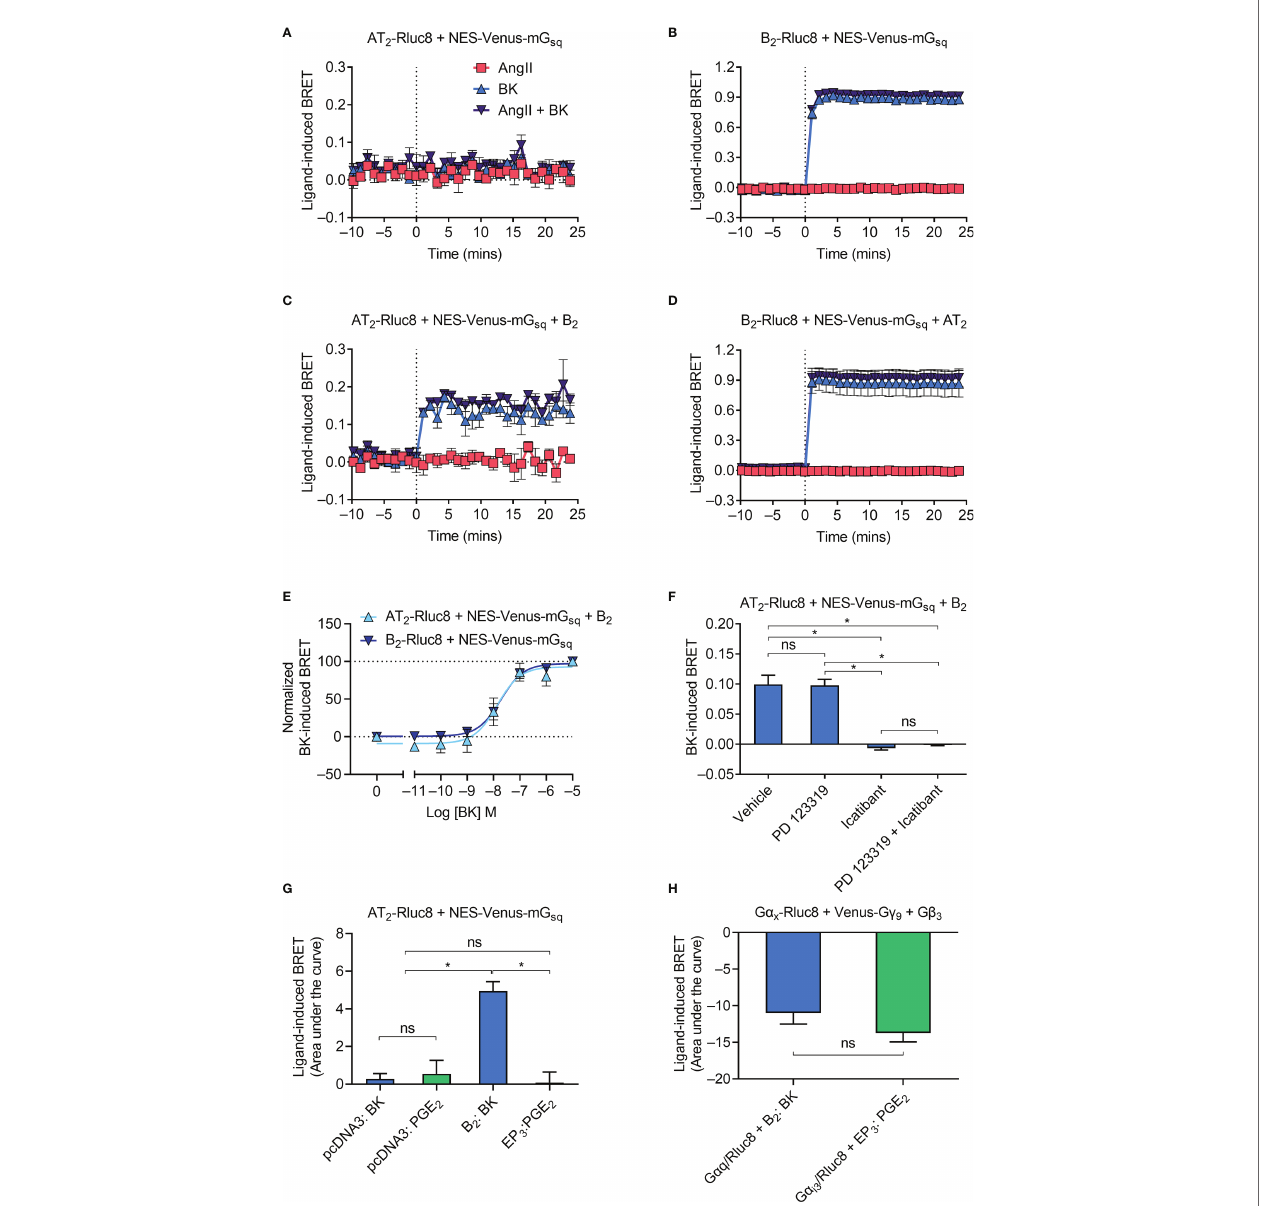
FIGURE 2 | G a q recruitment to the AT 2 -B 2 heteromer. HEK293FT cells were transfected with plasmid cDNA as described on graphs. (A – D) Time course analysis showing recruitment of NES-Venus-mG sq to receptors following addition of ligands at 0 mins. (E) BK concentration-response analysis showing recruitment of NES-Venus-mG sq to receptors. Normalized data taken from BRET assays at 17 min after agonist addition. (F) NES-Venus-mG sq Receptor-HIT assay in the presence of 50 m M antagonists (or vehicle) and 0.1 m M BK. Data are from BRET assays at 17 min after agonist addition. *p < 0.05; ns, not signi fi cant (one-way ANOVA with Tukey ’ s multiple comparisons test). (G) Area under the curve ligand-induced BRET data. *p < 0.05; ns, not signi fi cant (one- way ANOVA with Tukey ’ s multiple comparisons test). (H) Area under the curve ligand-induced BRET data. *p < 0.05; ns, not signi fi cant (unpaired t -test). All data are presented as mean ± SEM of ≥ three independent experiments performed in